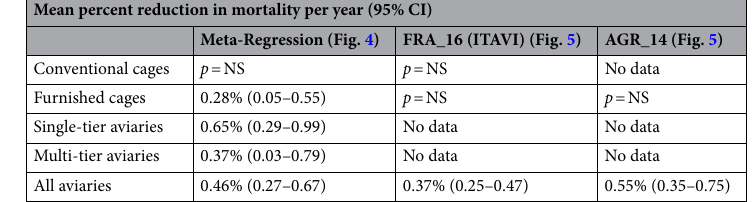
Table 3. Mean percent reduction in laying hen mortality in different indoor housing systems at 60 weeks per year (95% CI) as determined from meta-regressions (Fig. 4) and for independent data sources (Fig. 5: FRA_16; AGR_14). Coefficients were back-transformed to natural